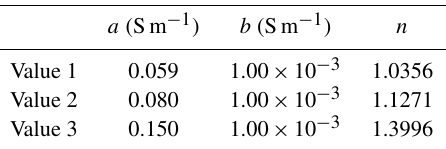
Table 1. Parameters used to predict volumetric water content in the Waxman and Smits model. Sensitivity analysis of WS using 27 simulations (for N parameters and m values, simulation num- ber is N m